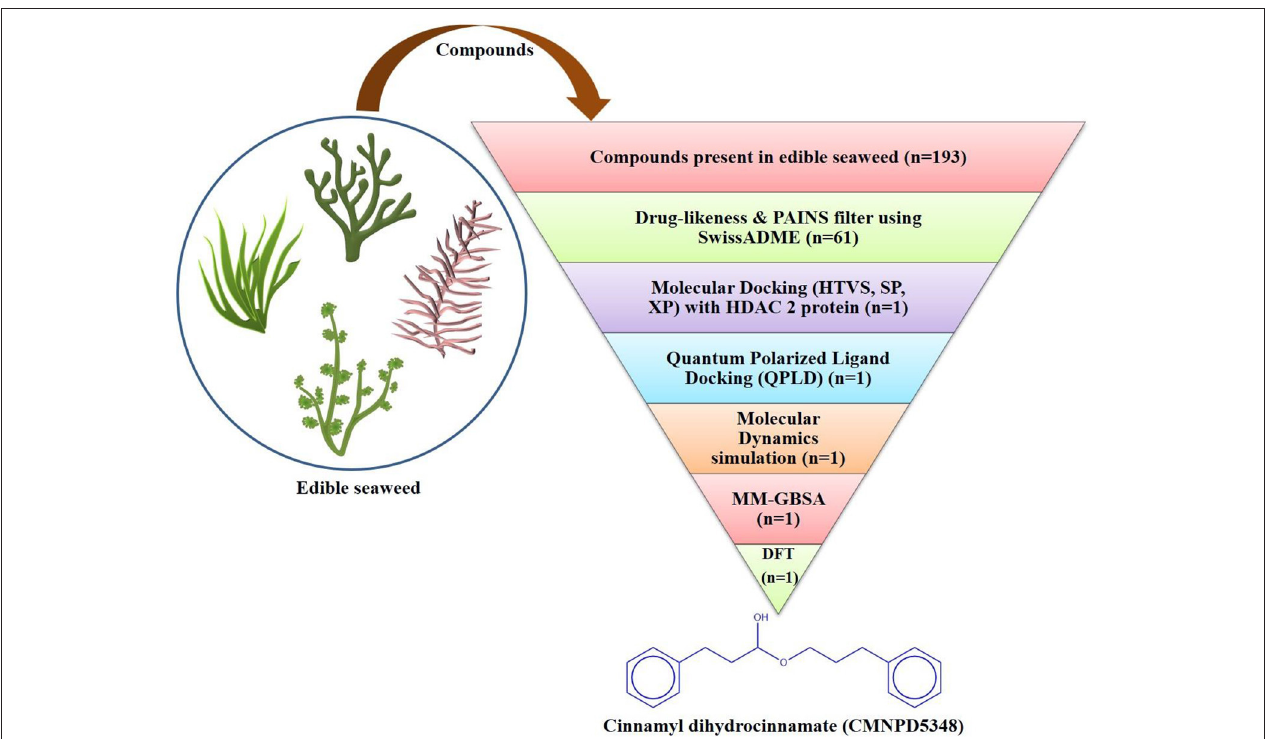
FIGURE 1 | Flowchart of the virtual screening workflow for identification of prospective HDAC 2 inhibitor from edible seaweed.